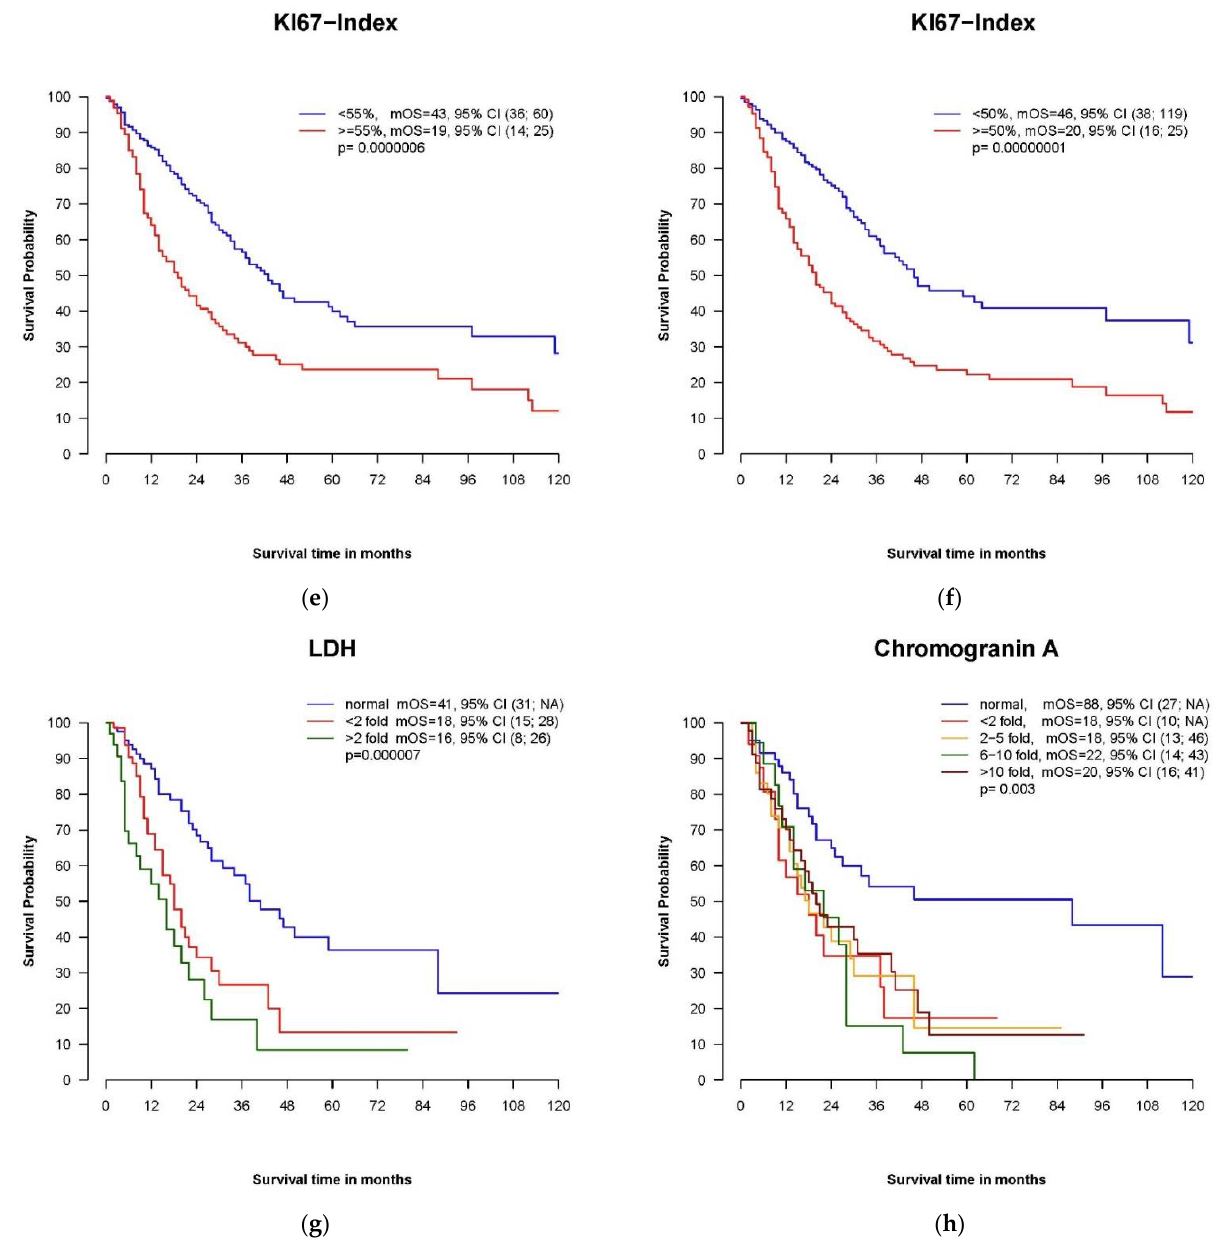
Figure 3. Kaplan–Meier plots of putative prognostic factors. ( a ) Overall survival in patients with ECOG performance statuses of 0, 1 and 2 or worse. ECOG: Eastern Co-operative Oncology Group Performance Status. ( b ): Overall survival depending on stage. ( c ) Overall survival depending on the primary tumor localization in metastatic disease. GI, gastrointestinal; CUP, cancer of unknown primary. ( d ) Overall survival depending on morphology: NEC versus NET. ( e ) Overall survival by proliferation rate: Ki67 ≥ 55% versus Ki67 < 55%. ( f ) Overall survival by proliferation rate: Ki67 ≥ 50% versus Ki67 < 50%. ( g ) Overall survival by serum level of LDH (lactate dehydrogenase). ( h ) Overall survival by plasma level of chromogranin A (CgA).